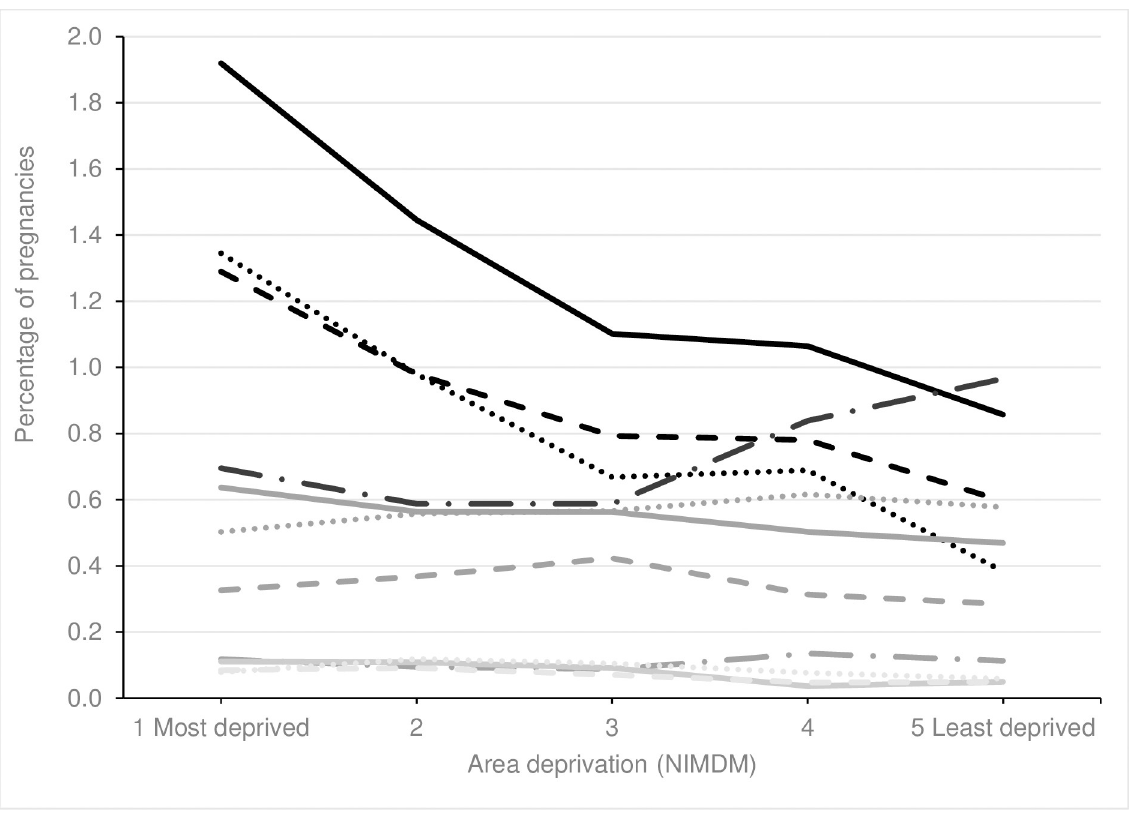
Fig 7. Percentage of pregnancies exposed to less common therapeutic classes of medication across area of deprivation (NIMDM). Solid black line = tranquilizers; Dotted black line = sedatives; Dashed black line = antiepileptics a ; Long dashed black line = anticoagulants; Solid grey line = antivirals b ; Dotted gey line = insulin; Dashed grey line = antihypertensives; Long dashed grey line = immunosuppressants; Solid light grey line = drug dependency a ; Dotted light grey line = antacids; Dashed light grey line = diuretics c .